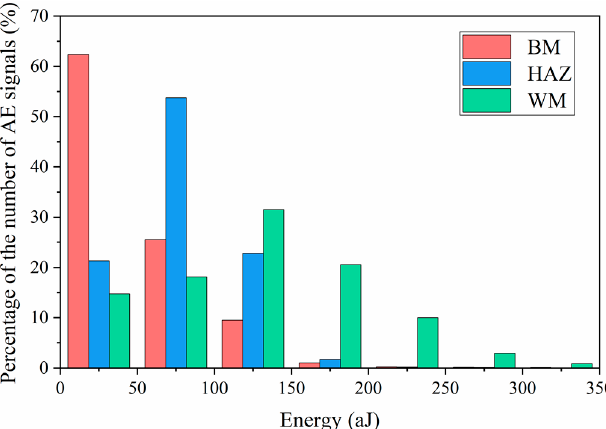
Figure 10. The statistical results of energy distribution of different specimens.